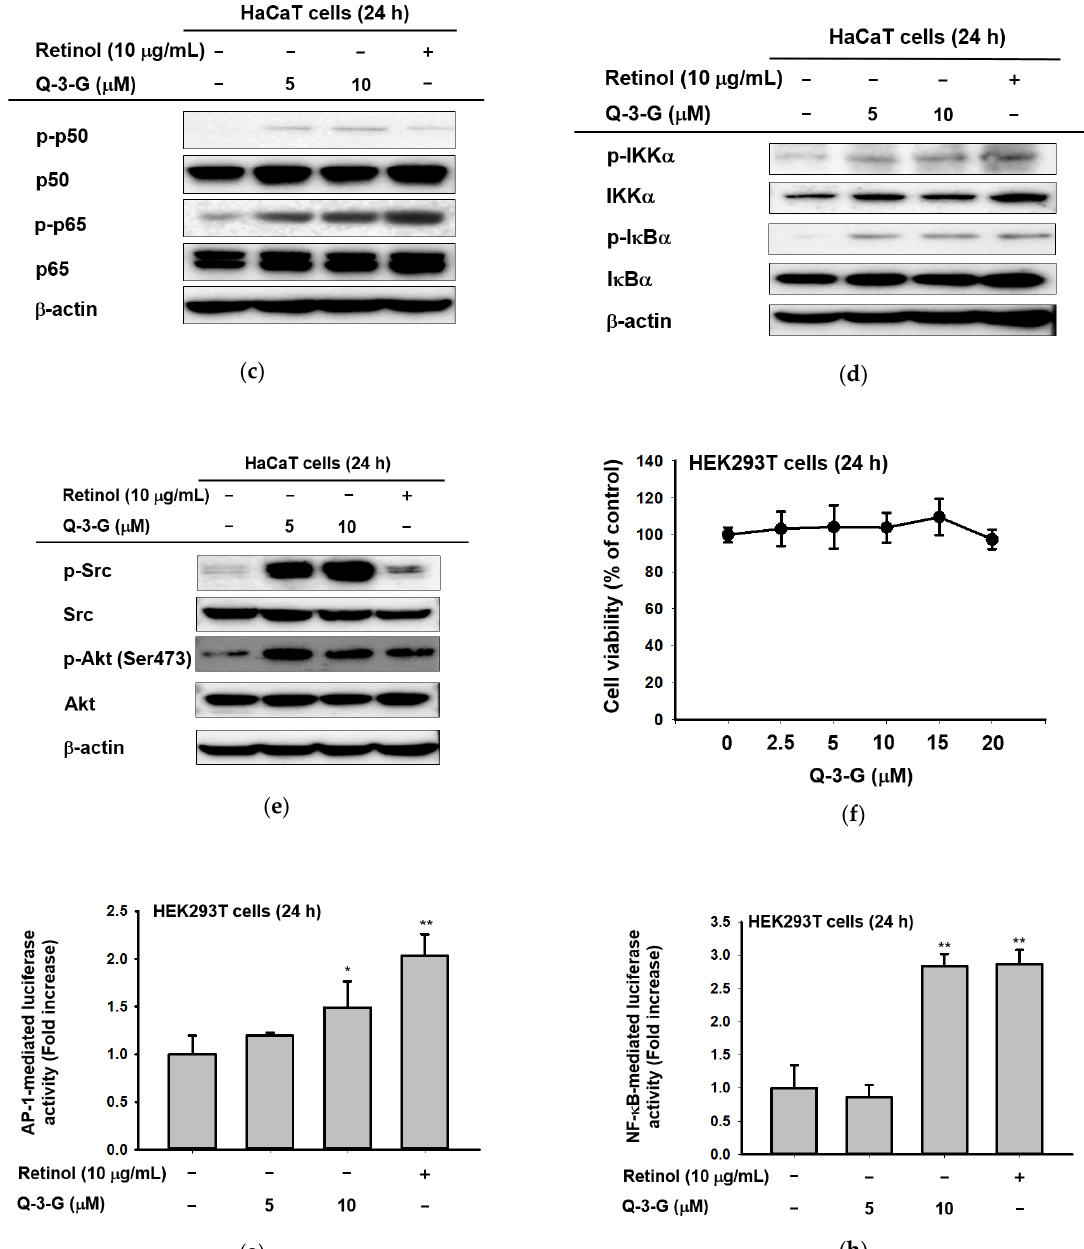
Figure 4. The effects of Q-3-G on AP-1 and the NF- κ B signaling pathways. ( a ) HaCaT cells were incubated with Q-3-G (2.5, 5, and 10 µ M) and retinol (10 µ g/mL) for 24 h, using immunoblot analysis to determine the phosphorylation of c-Jun. ( b ) HaCaT cells were incubated with Q-3-G (2.5, 5, and 10 µ M)) and retinol (10 µ g/mL) for 24 h, using immunoblot analysis to determine the phosphorylation of TAK1, MKK4, and JNK. ( c , d ) The phosphorylation of p50, p65 ( c ), IKK α , and I κ B α ( d ) was determined by immunoblot analysis after incubation of HaCaT cells with Q-3-G (5 and 10 µ M) and retinol (10 µ g/mL) for 24 h. ( e ) The effects of Q-3-G on the phosphorylation of Src and Akt (Ser 473) were measured by immunoblot analysis with Q-3-G (5 to 10 µ M) and retinol (10 µ g/mL). The expression of β -actin was used as control protein. ( f ) Treatment of HEK293T cells with various concentrations of Q-3-G (0–20 µ M) for 24 h, using a conventional MTT assay to determine cell viability. ( g , h ) HEK293T cells overexpressing AP-1-luc ( g ) and NF- κ B-Luc ( h ) were treated with Q-3-G (5 and 10 µ M) and retinol (10 µ g/mL) for 24 h. Results ( f , g , h ) are expressed as mean ± SD. * p < 0.05 and ** p < 0.01 compared to normal (no